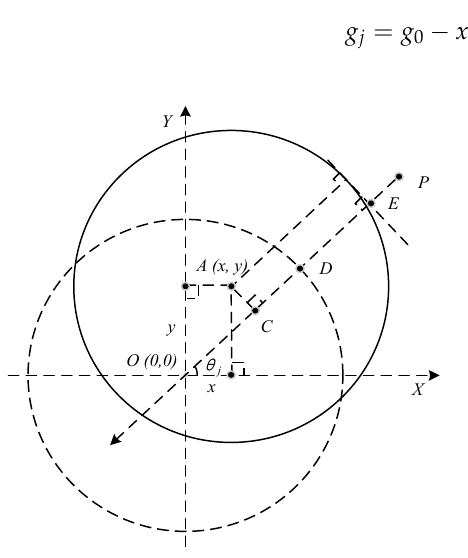
Figure 2. Air gap vs. rotor position.